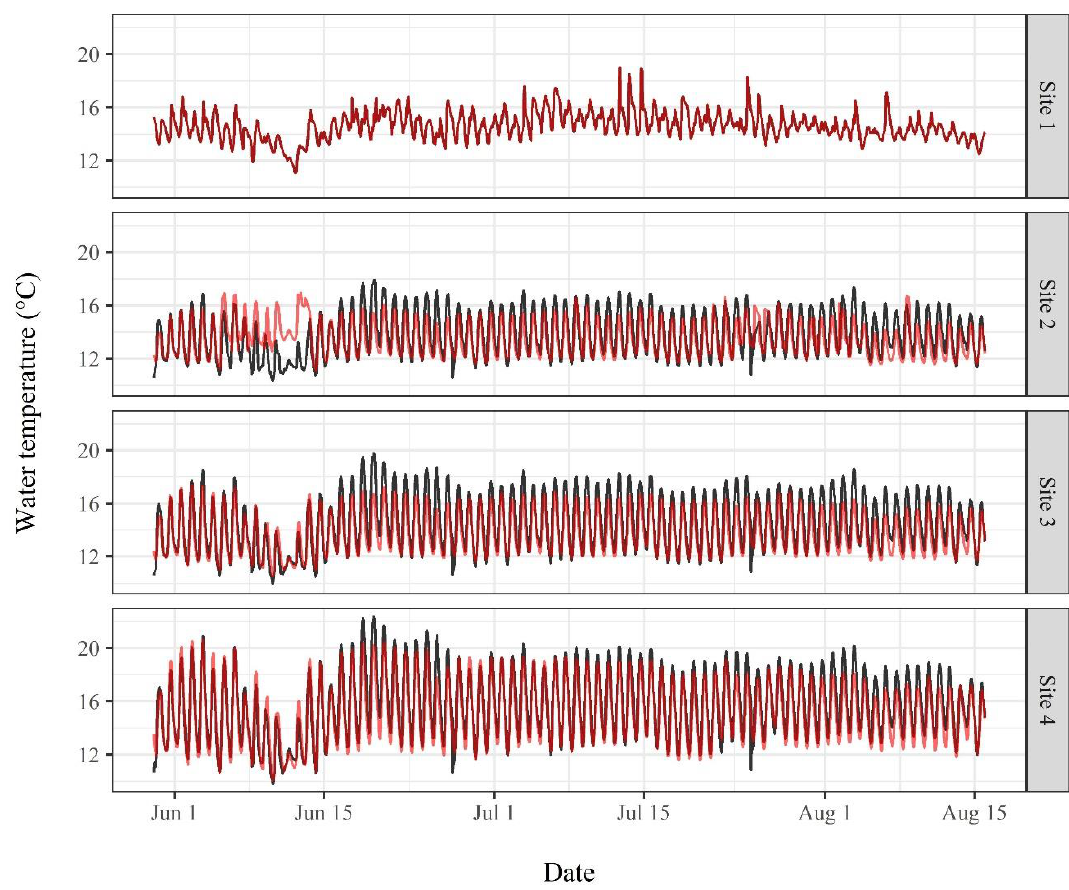
Figure A2. Plots of the modeled (black line) water temperature versus observed (red line) water temperatures for the monthly canopy growth simulation.